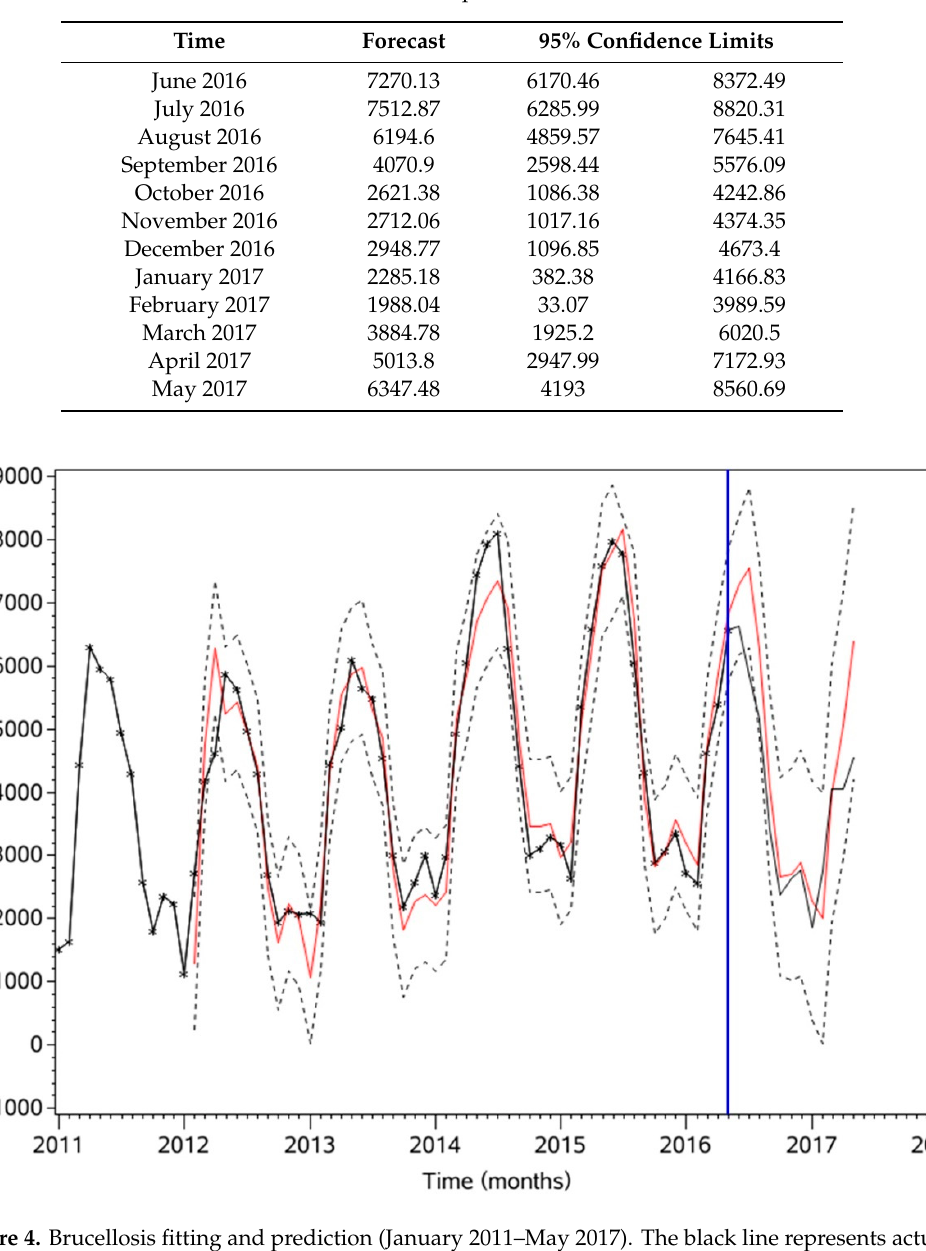
Table 5. Brucellosis prediction results.